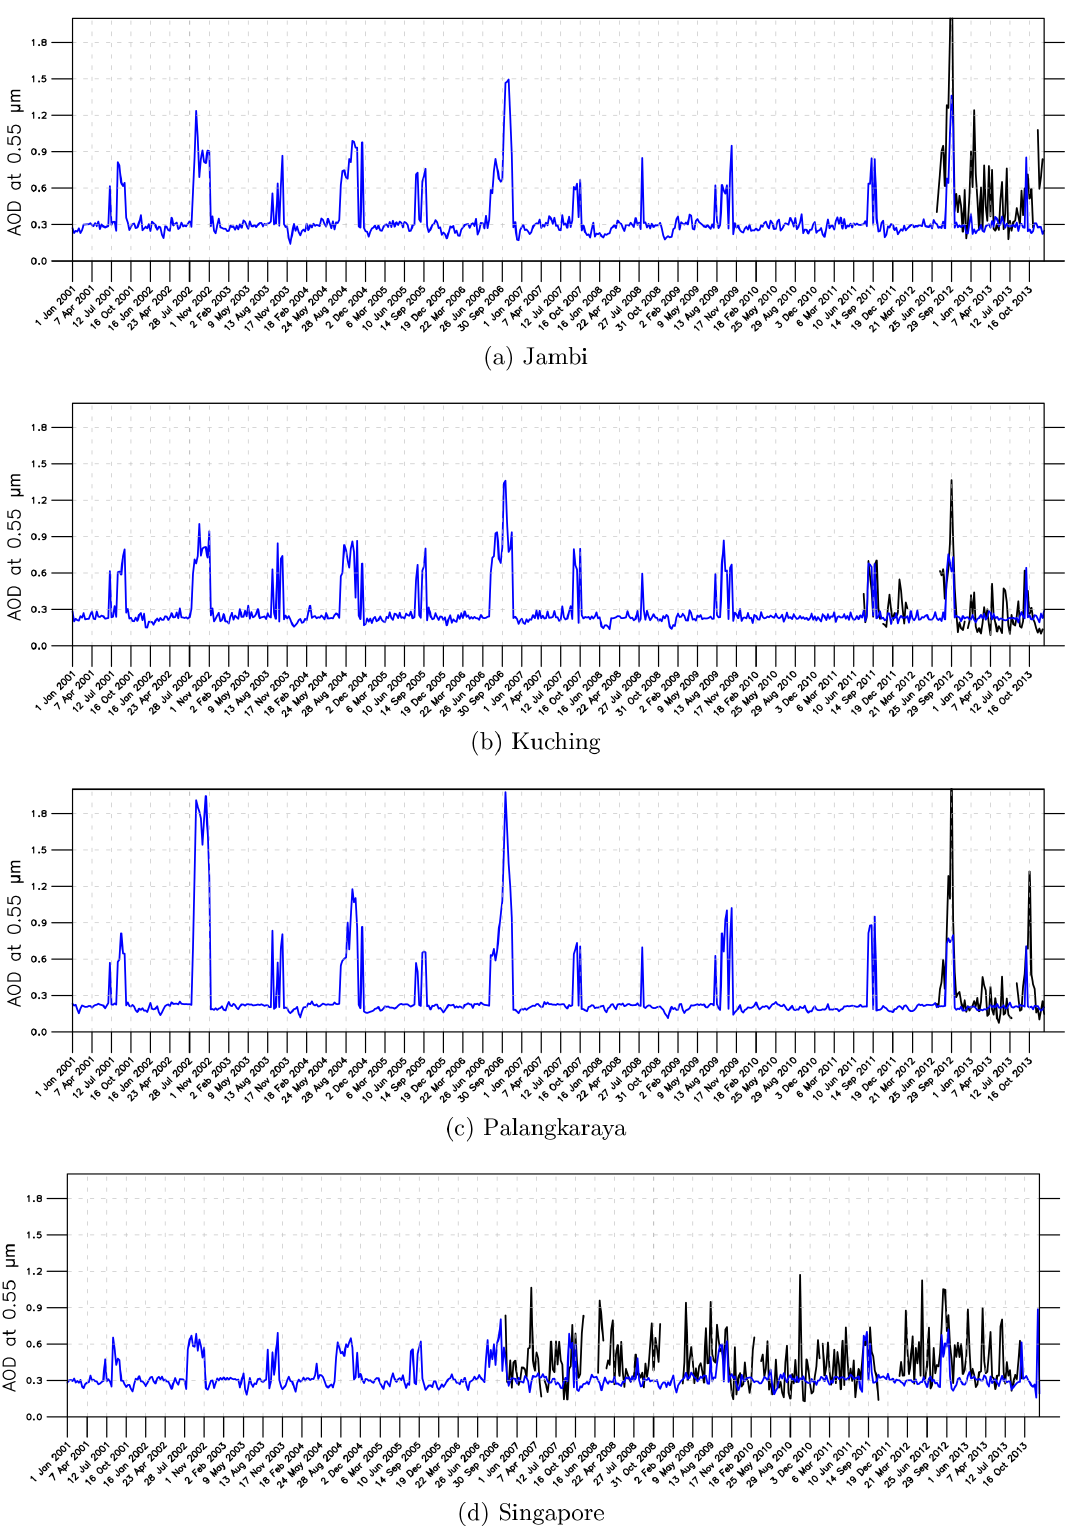
Figure 6. Temporal series of 8-day AERONET AOD (black) and AOD south (blue) at Jambi (a) , Kuching (b) , Palangkaraya (c) , and Singa- pore (d)